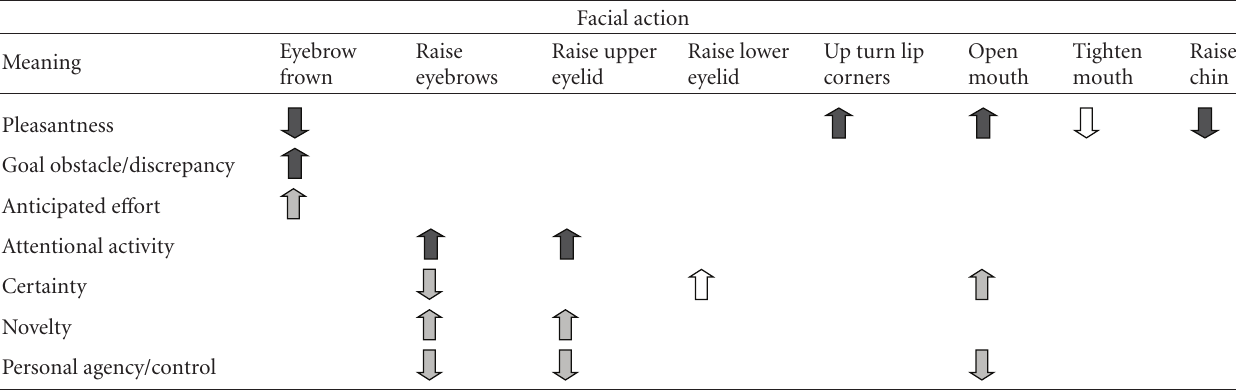
Table 2: Emotional e ff ect of facial action [17]. Up arrows indicate that activation of the facial action increases the corresponding emotional e ff ect while down arrows mean the opposite. Darker arrows show stronger